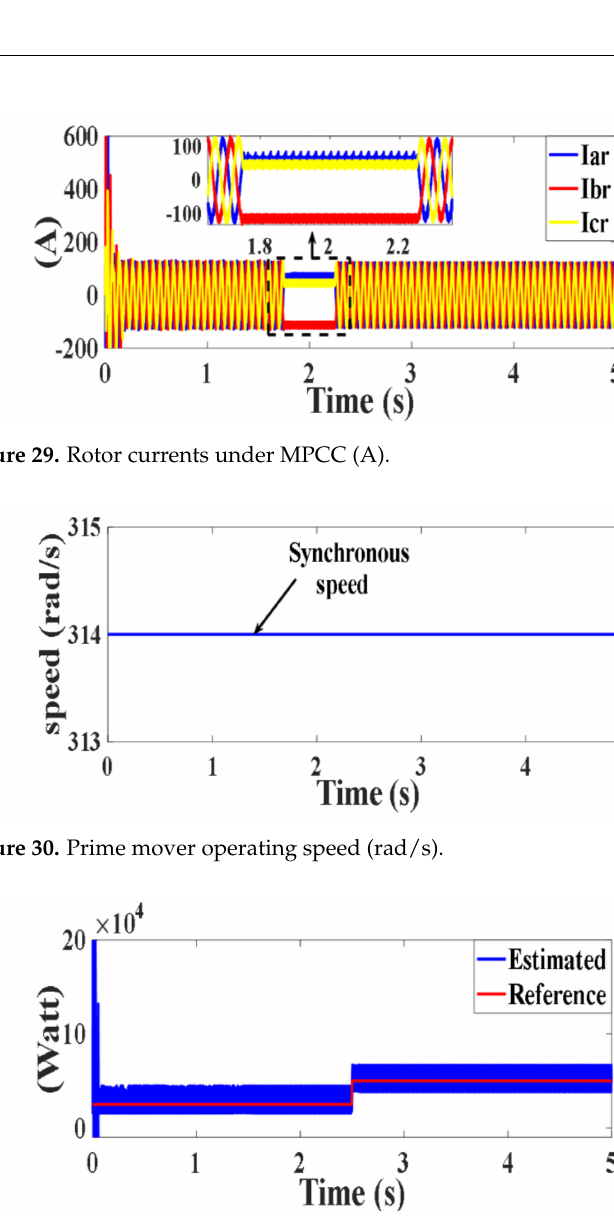
Figure 31. Active power under MPCC (Watt).